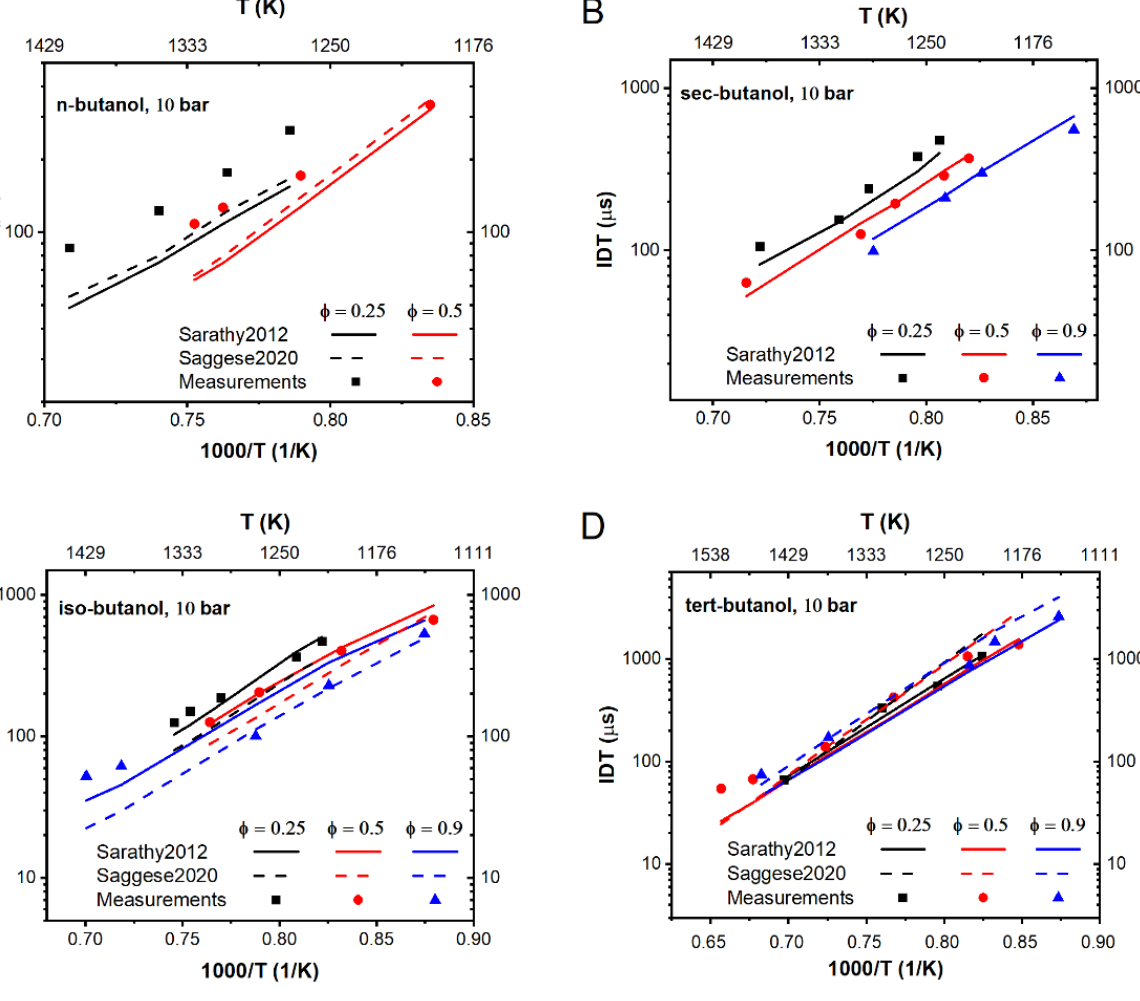
Figure 4. IDTs of ( A ) n-butanol, ( B ) sec-butanol, ( C ) iso-butanol, and ( D ) tert-butanol measured in the HPST at 10 bar and ϕ = 0.25, 0.5, and 0.9.